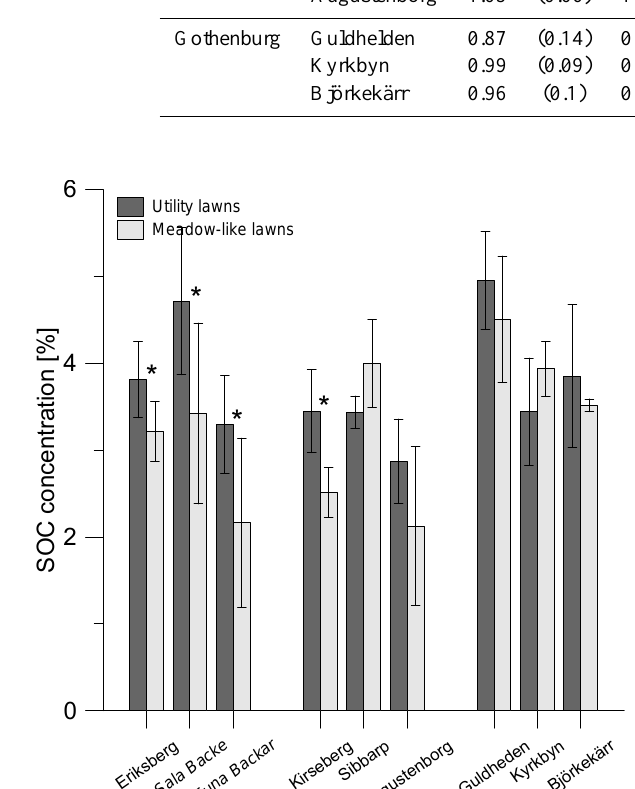
Figure 5. Difference in soil organic carbon (SOC) stock between utility and meadow-like lawns as a function of difference in above- ground NPP for all